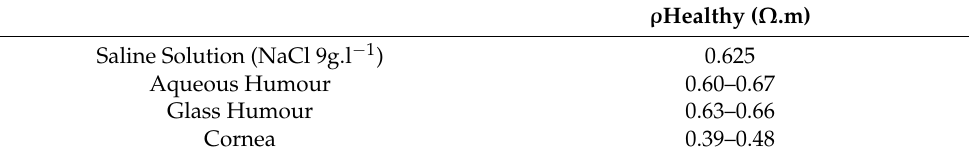
Table 1. Characteristics of the resistivities of the different components of the eye